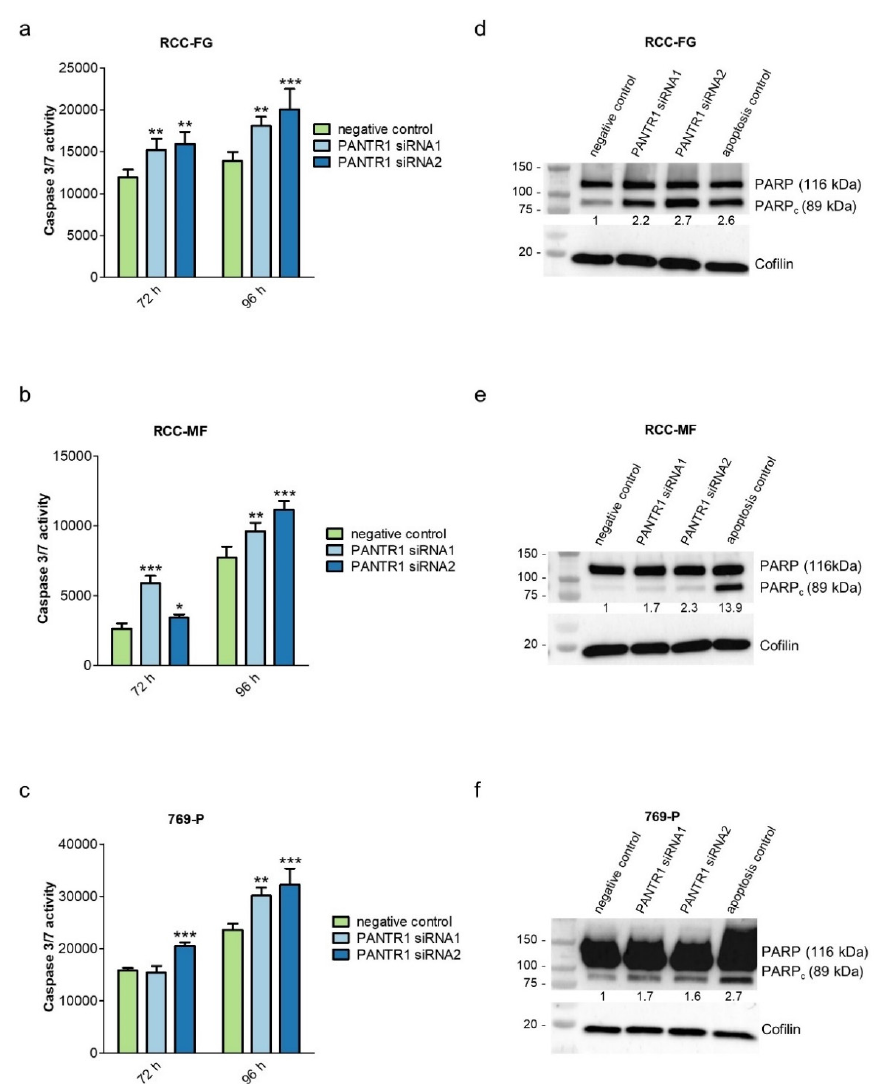
Figure 3. PANTR1 knock-down triggers induction of apoptosis. ( a–c ) Caspase 3/7 assay either under control conditions (negative control siRNA) or after siRNA-mediated knock-down of PANTR1 72 or 96 h after transfection; n = 4; mean ± SD. * p < 0.05, ** p < 0.01, *** p < 0.001. ( d–f ) Results of Western Blot analysis of PARP staining showing levels of full-length PARP (116 kDa) and cleaved PARP (89 kDa) in PANTR1 silenced cells 96 h post-transfection compared to control cells. Cofilin was used as loading control. Values between the blots represent the densitometric analysis of the cleaved PARP1 bands (PARP c , 89 kDa) normalized to the housekeeping protein cofilin. The negative control band was set as reference (=1). Uncropped images can be found in Figure S4.